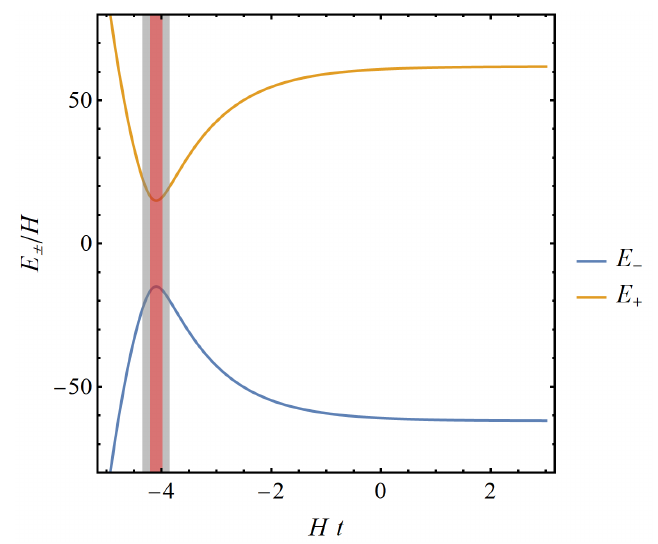
Figure 1 . The instantaneous eigenvalues of the Hamiltonian in dS. Here we have chosen m = 15 H , κ = 60 H , or, after translating to LZ model parameters, η = 15 H , γ = 120 H 2 . The gray band corresponds to the naive time scale 4 η = 0 . 5 H − 1 while the red band corresponds to the actual γ q 2 π production width ∆ t ∗ = = 0 . 23 H − 1 . As long as κ (cid:29) m , the light pink band is narrow enough γ so that the expansion of spacetime becomes irrelevant, and the instantaneous energy eigenvalues approach to that of a LZ